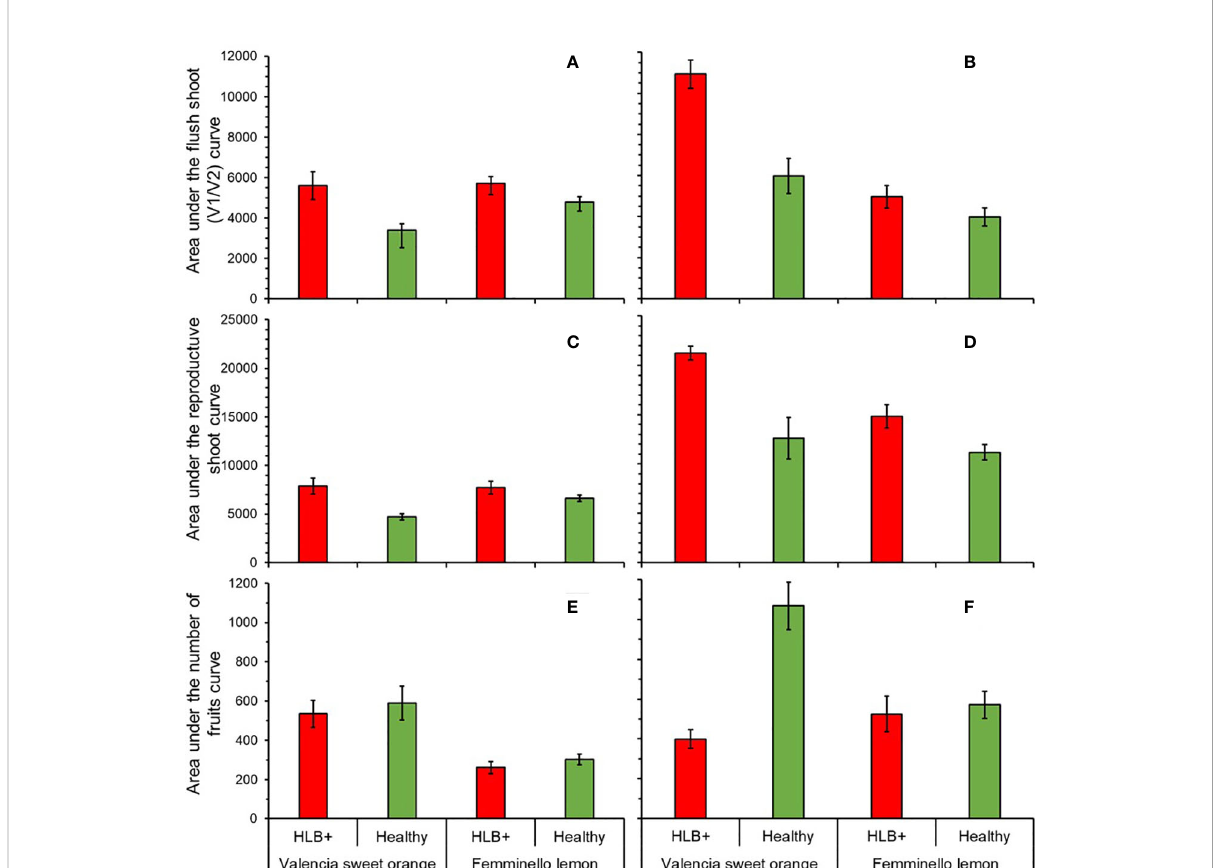
FIGURE 6 Area under the curve of the percentage of branches with vegetative new shoots in stages V1 and V2 (A, B) , reproductive shoots (C, D) and number of fruits per branch (E, F) , from the 1 st to 16 th (A, C, E ; n = 10) and 24 th to 97 th ( B, D, F ; n = 5) assessment dates in ‘ Femminello ’ lemon and ‘ Valencia ’ sweet orange